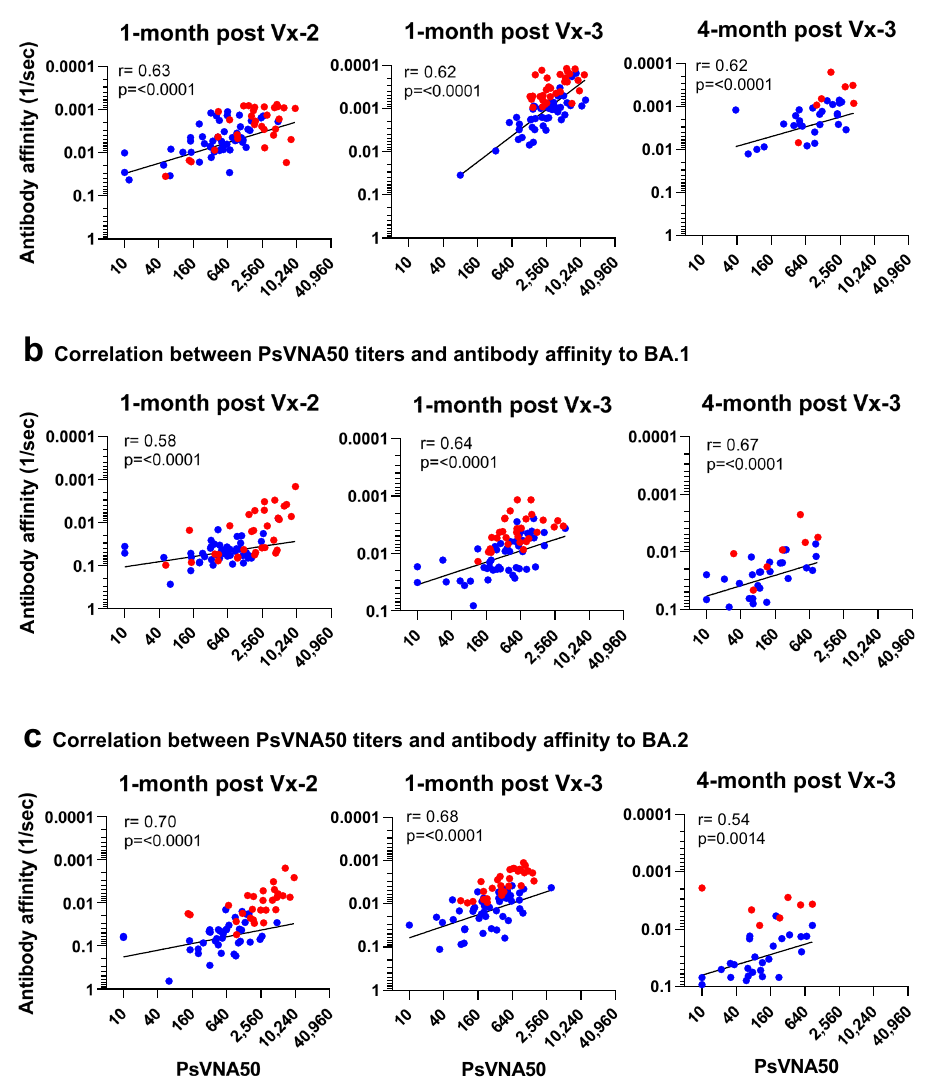
Fig. 3 | Relationship of post-vaccination SARS-CoV-2 serum neutralizing anti- bodies in COVID convalescent and naïve adults with antibody af fi nity against SARS-CoV-2 spike protein. Correlation analysis between serum PsVNA50 neu- tralization antibody titers generated following second and third vaccination of COVID exposed ( n =31) and unexposed naïve ( n =50) adults against vaccine-